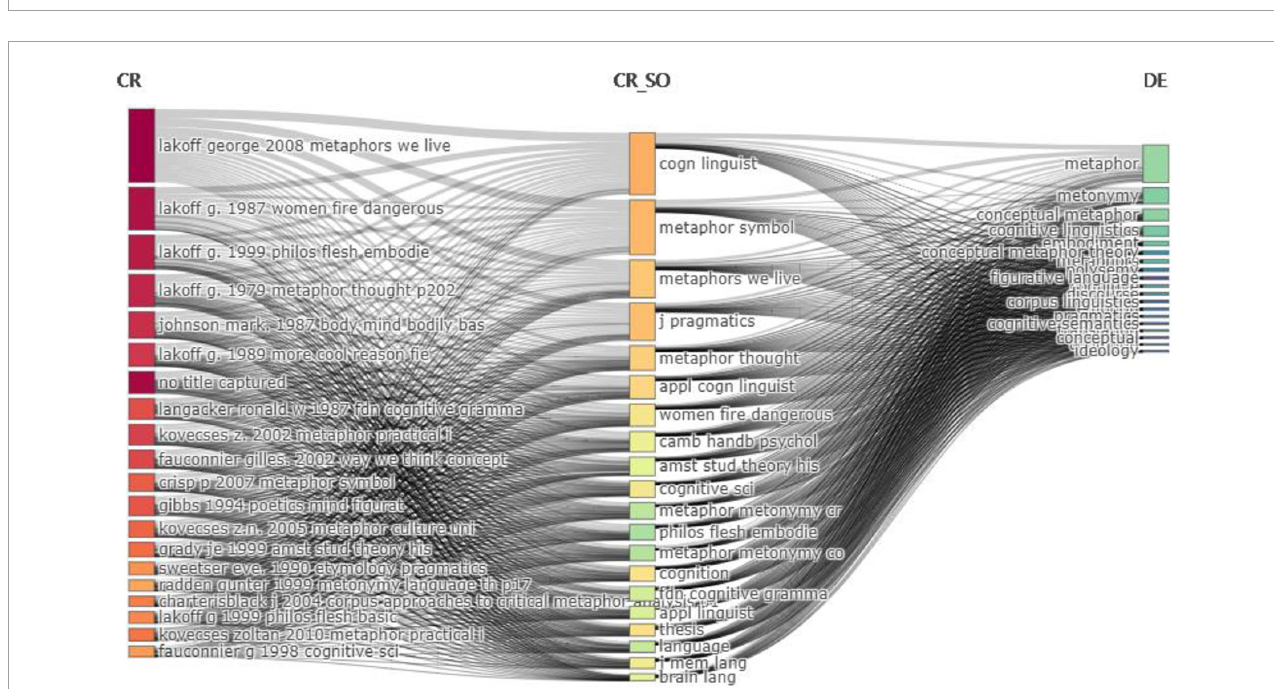
FIGURE8 Time slice 2: thematic evolution during 2017–2022.